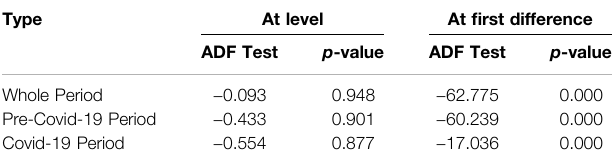
TABLE 2 | Stationarity test of stock index prices during all time frames.